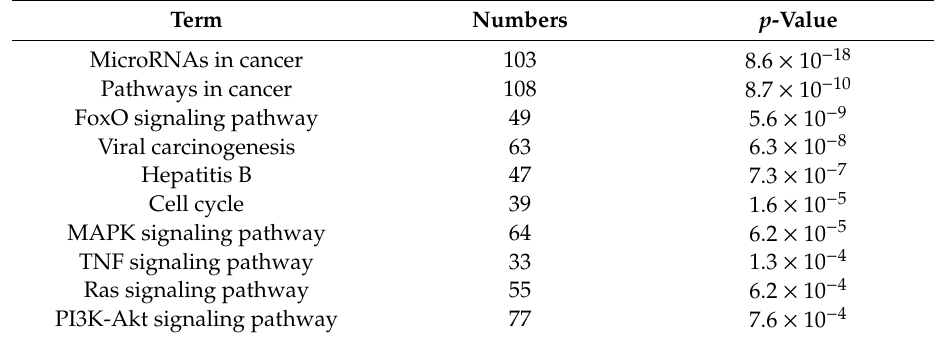
Table 3. The pathway enrichment analysis of proteins by applying the DAVID in core HPI-GEN during HBV